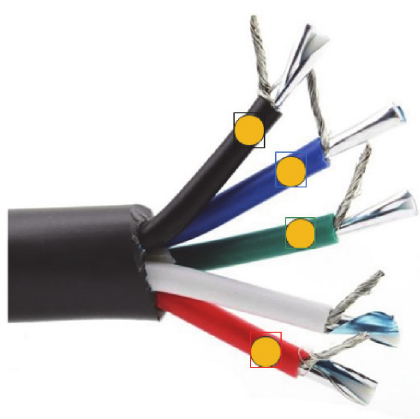
Figure 5: The purple rectangle representation of the area to be inspected on the data